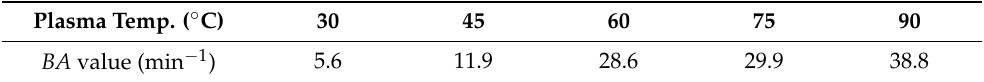
Table 1. Relationship between the plasma gas temperature and BA value.